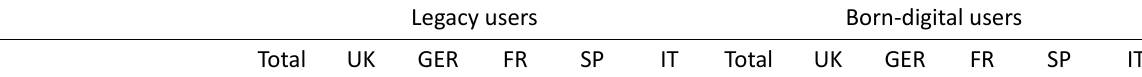
Table 4. Frequency distributions for sociodemographic variables, 2019